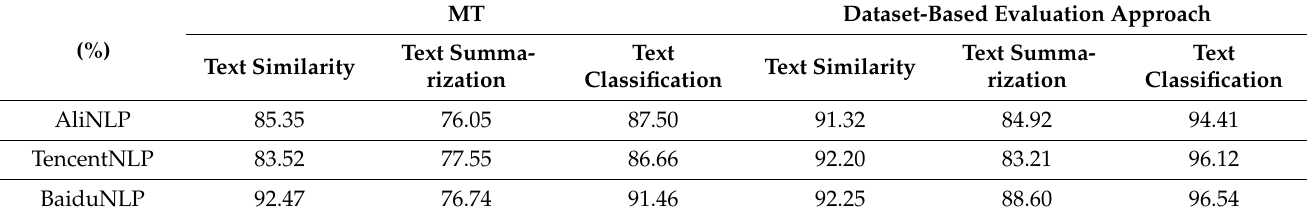
Table 12. Comparative experimental result: the accuracies reported by MT and dataset-based evaluation